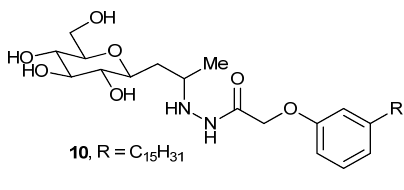
Figure 8. D ‐ glucose based glycolipids. Figure 8. D -glucose based Figure 8. D -glucose based glycolipids.